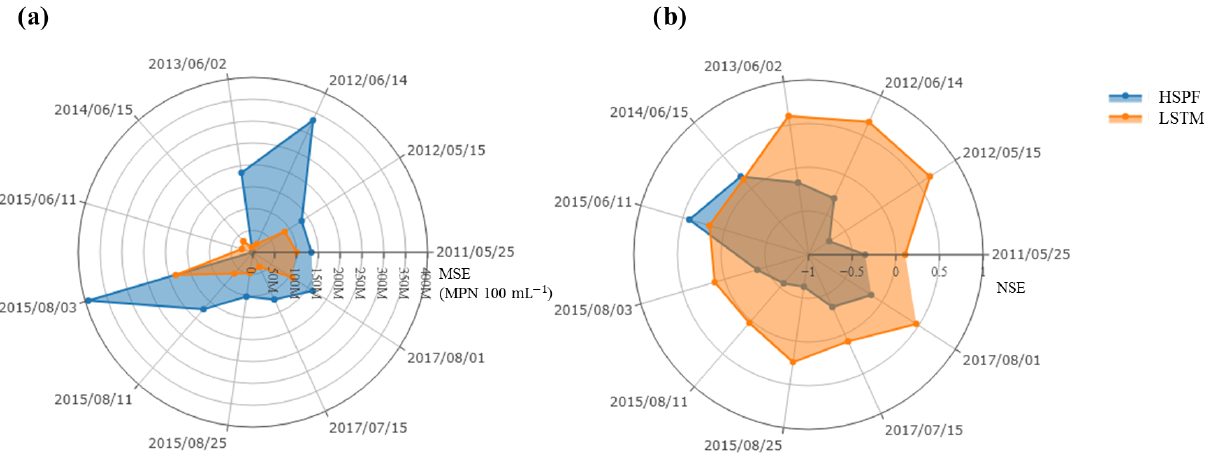
ther sediment transport nor the attachment/detachment of